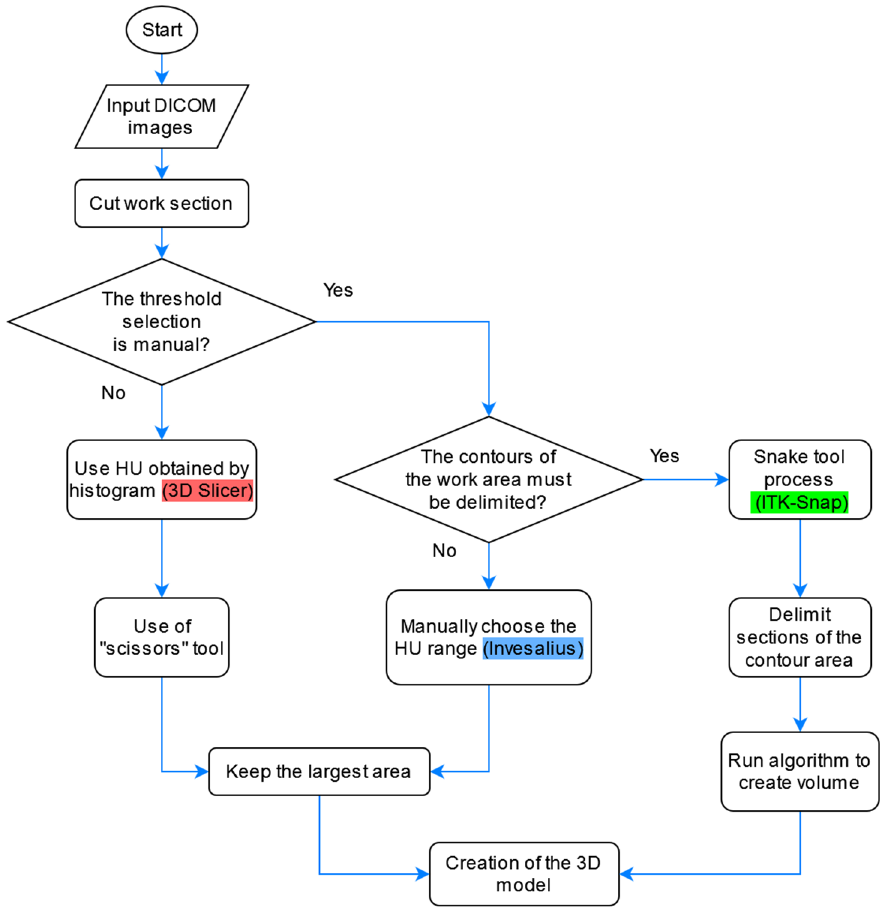
Figure 6. Flowcharts for the segmentation of the healthy part of the lung with the three software.